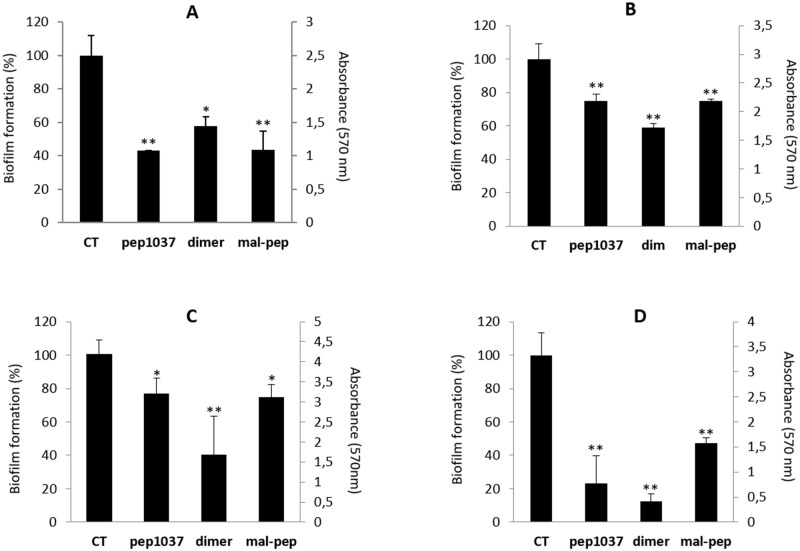
Inhibiting effect of 10 μg/mL of pep1037, cys-pep1037 dimer and mal-cys-pep1037 on the formation of P. aeruginosa ATCC 15442 (A), P. aeruginosa ATCC 27853 (B), B. cenocepacia K56-2 (C) and B. cenocepacia J2315 (D) biofilms.Error bars indicate the standard deviation of six replicates, and statistical significance was determined using one-way ANOVA (*, P < 0.01; **, P < 0.001 versus the control, denoted CT).